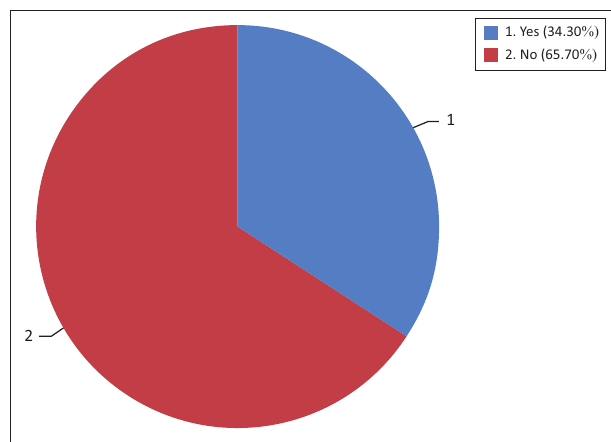
FIGURE 5: Respondents’ decision to relocate.